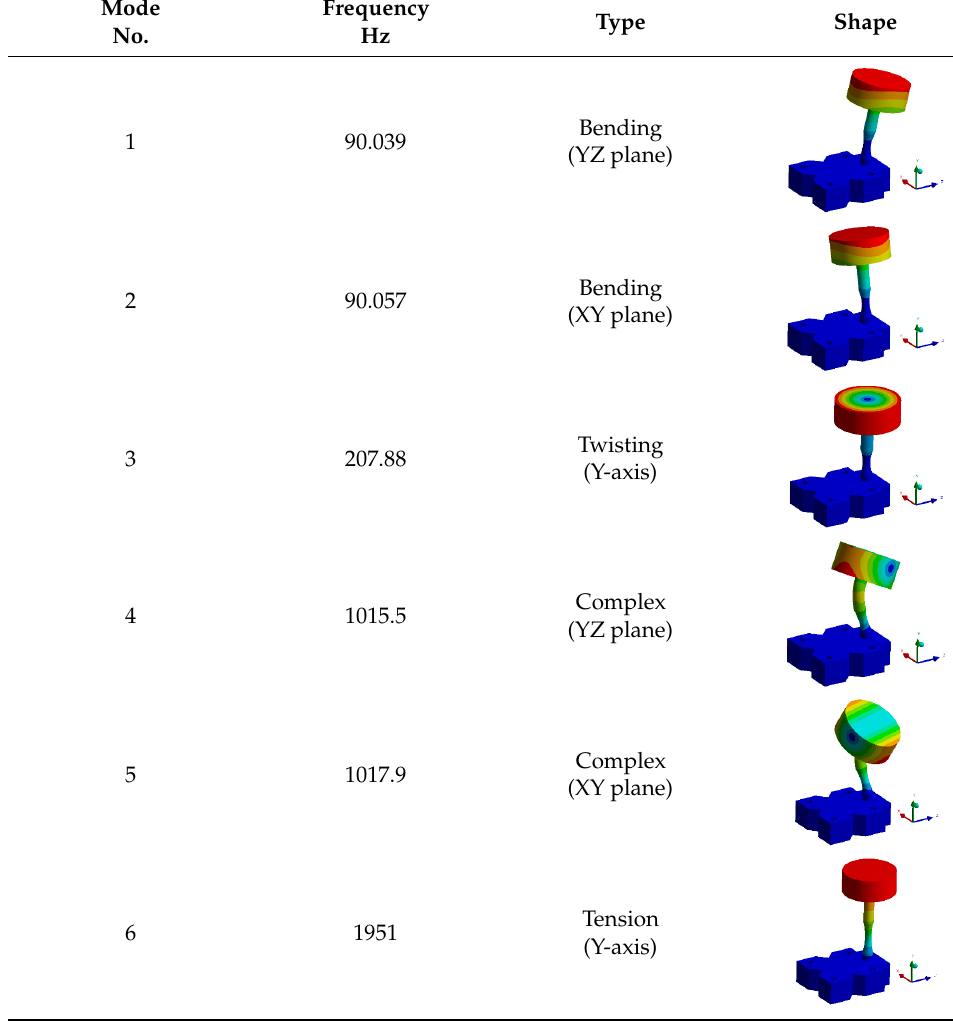
Table 7. Modal frequencies of the experimental test rig.